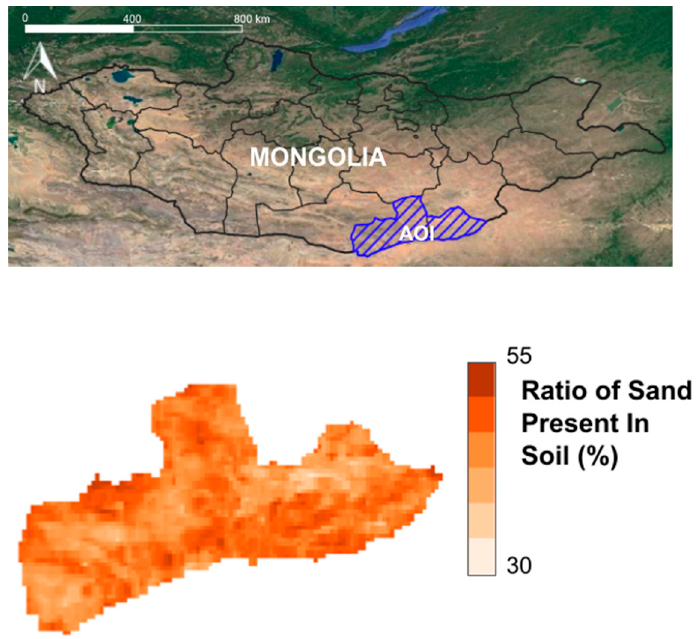
Figure 1. Map of our Area Of Interest (AOI) in Mongolia and map of percentage sand content in the study area. Borders overlayed on Google Earth satellite base map.